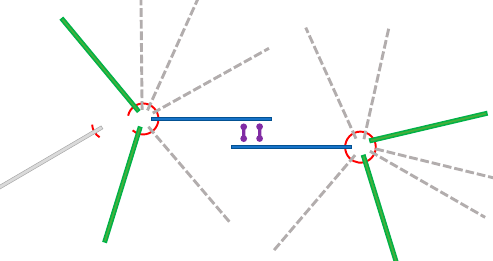
Figure 2. Schematic diagram of two microtubule aster structures for the contraction system. The aster structure was mediated by a DNA origami linker, indicated by red circles. The multimeric kinesin linker binds two microtubule filaments between asters to pull the asters closer, depicted as two dumbbells. Aster fragments are depicted as solid line filaments, omitting the dashed line filaments. A gray filament on the left side is an example of the dissociation that may occur to fragment the aster structure.